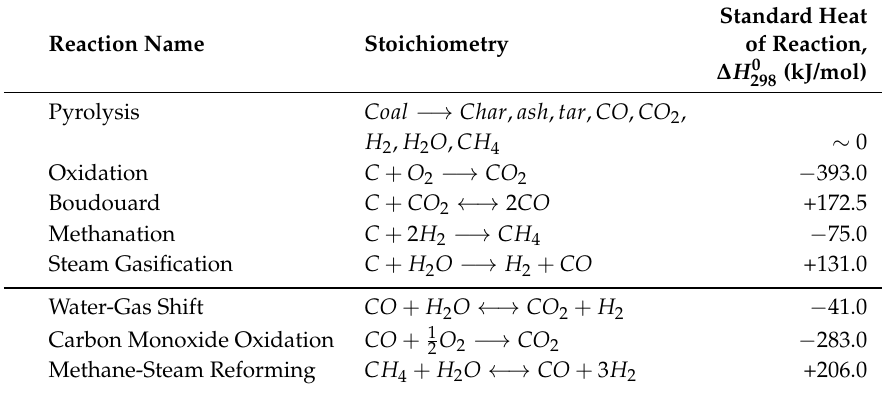
Table 1. The most relevant heterogeneous (gas–char) and homogeneous (gas phase) chemical reactions that occur in underground coal gasification